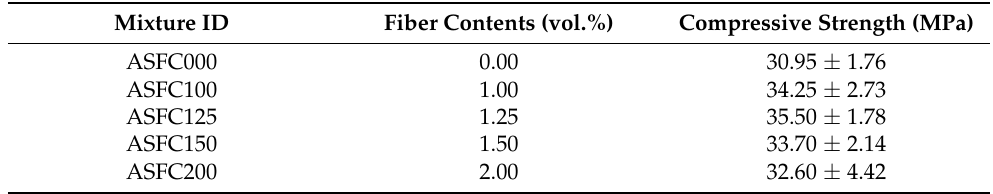
Table 5. Uniaxial compressive strength.